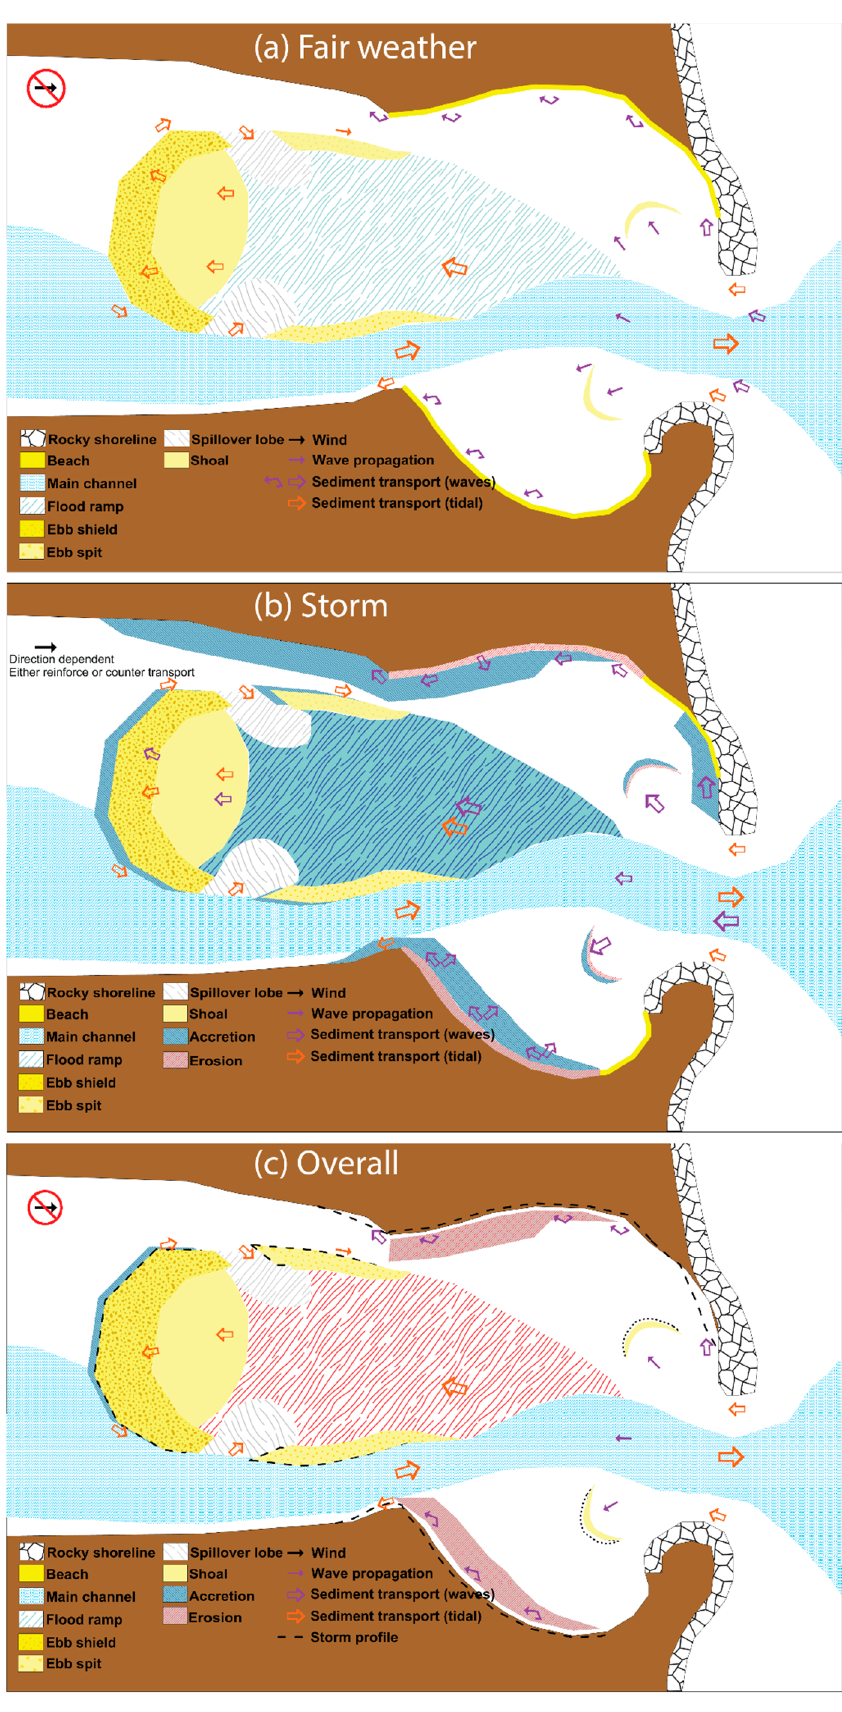
Figure 7. Conceptual model of FTD Morphology. Arrows are scaled for relative contribution to transport potential.